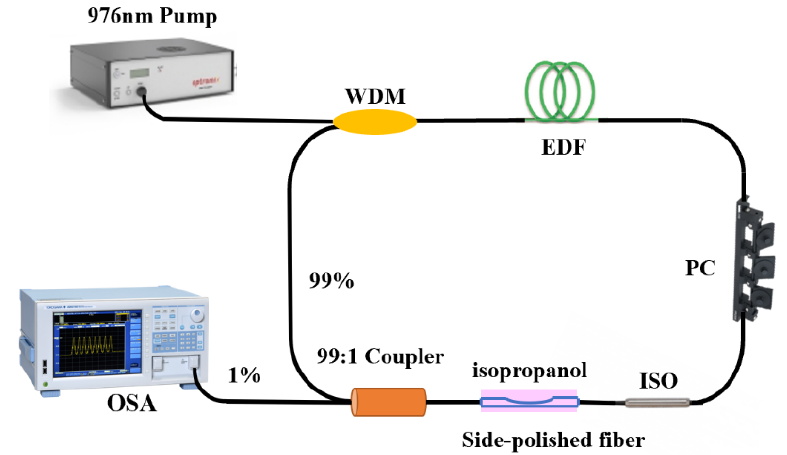
Figure 1. Experiment setup of the temperature FRL sensing system.